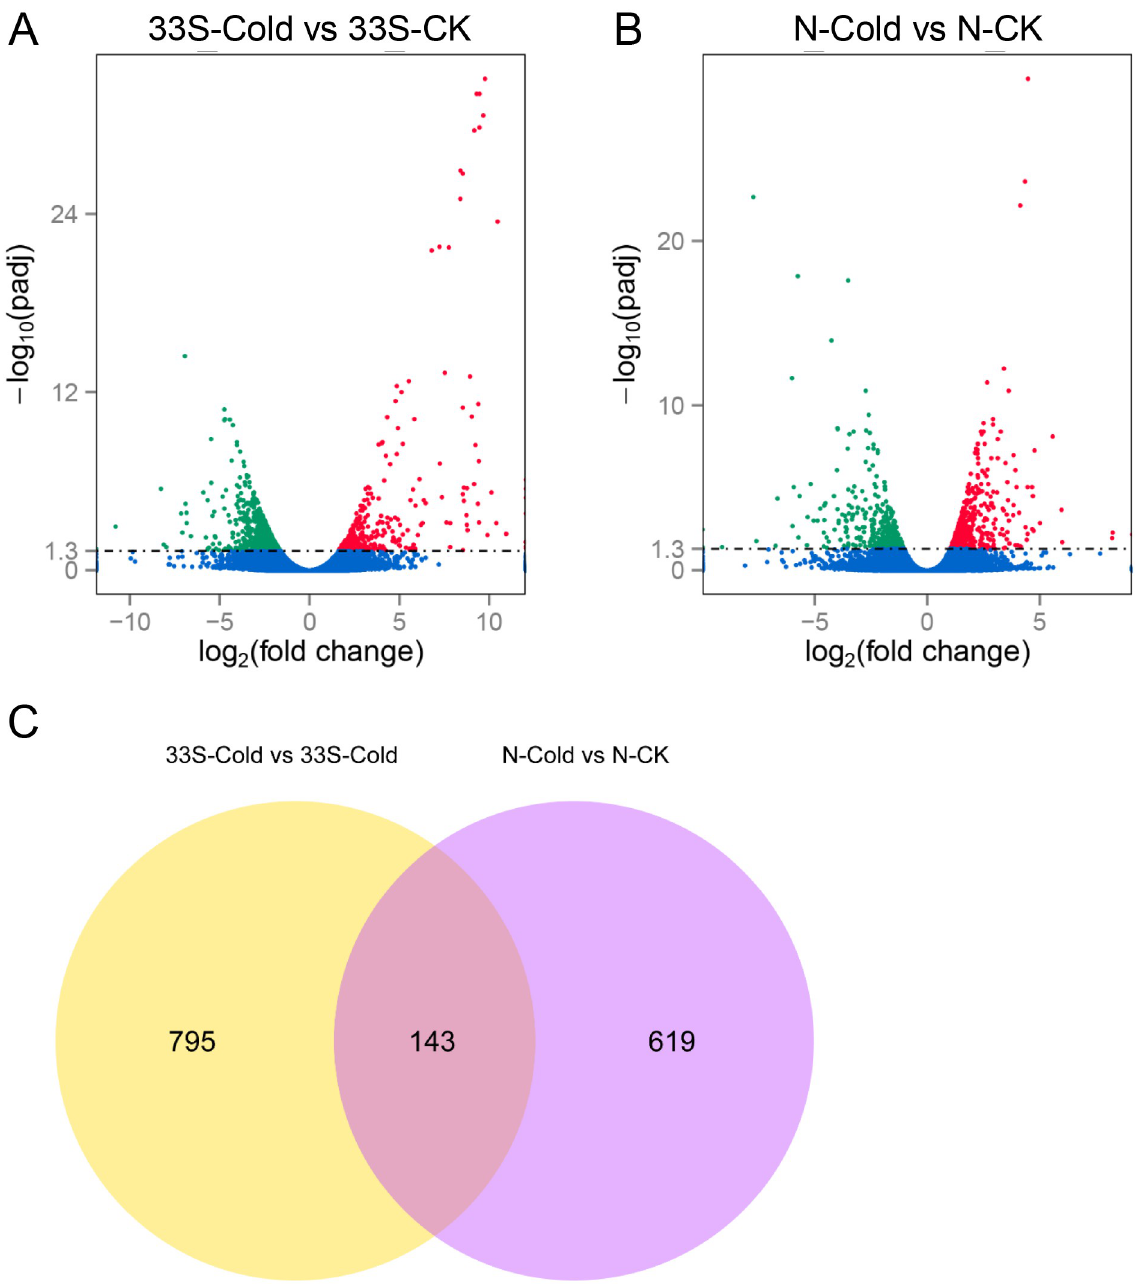
Fig 2. Number of DEGs after low temperature treatment in 33S and Nipponbare. A . Significantly up- or down-regulated genes in 33S-Cold vs. 33S-CK. B . Significantly up- or down-regulated genes in N-Cold vs. N-CK. C . Venn diagram indicating the number of DEGs common to 33S and Nipponbare. N indicates the variety of Nipponbare, CK indicates the control seedling not treated by cold temperature. DEGs were screened using a threshold of P < 0.05 and |log2FoldChange| > =